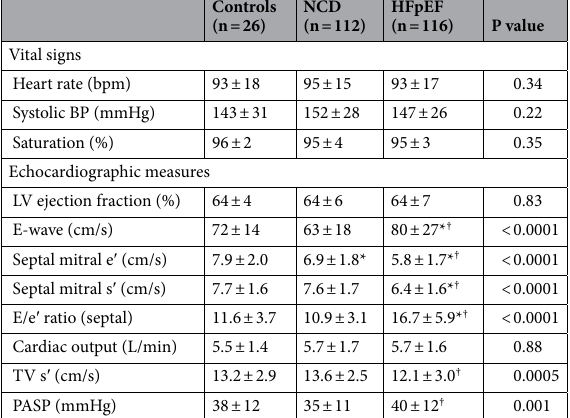
Table 2. Echocardiographic measures during matched 20W exercise. Data are mean ± SD or median (interquartile range). Final column reflects overall group differences. *p < 0.05 vs. Controls; † p < 0.05 vs. NCD. TV, tricuspid valvular; and other abbreviations as in Table 1.